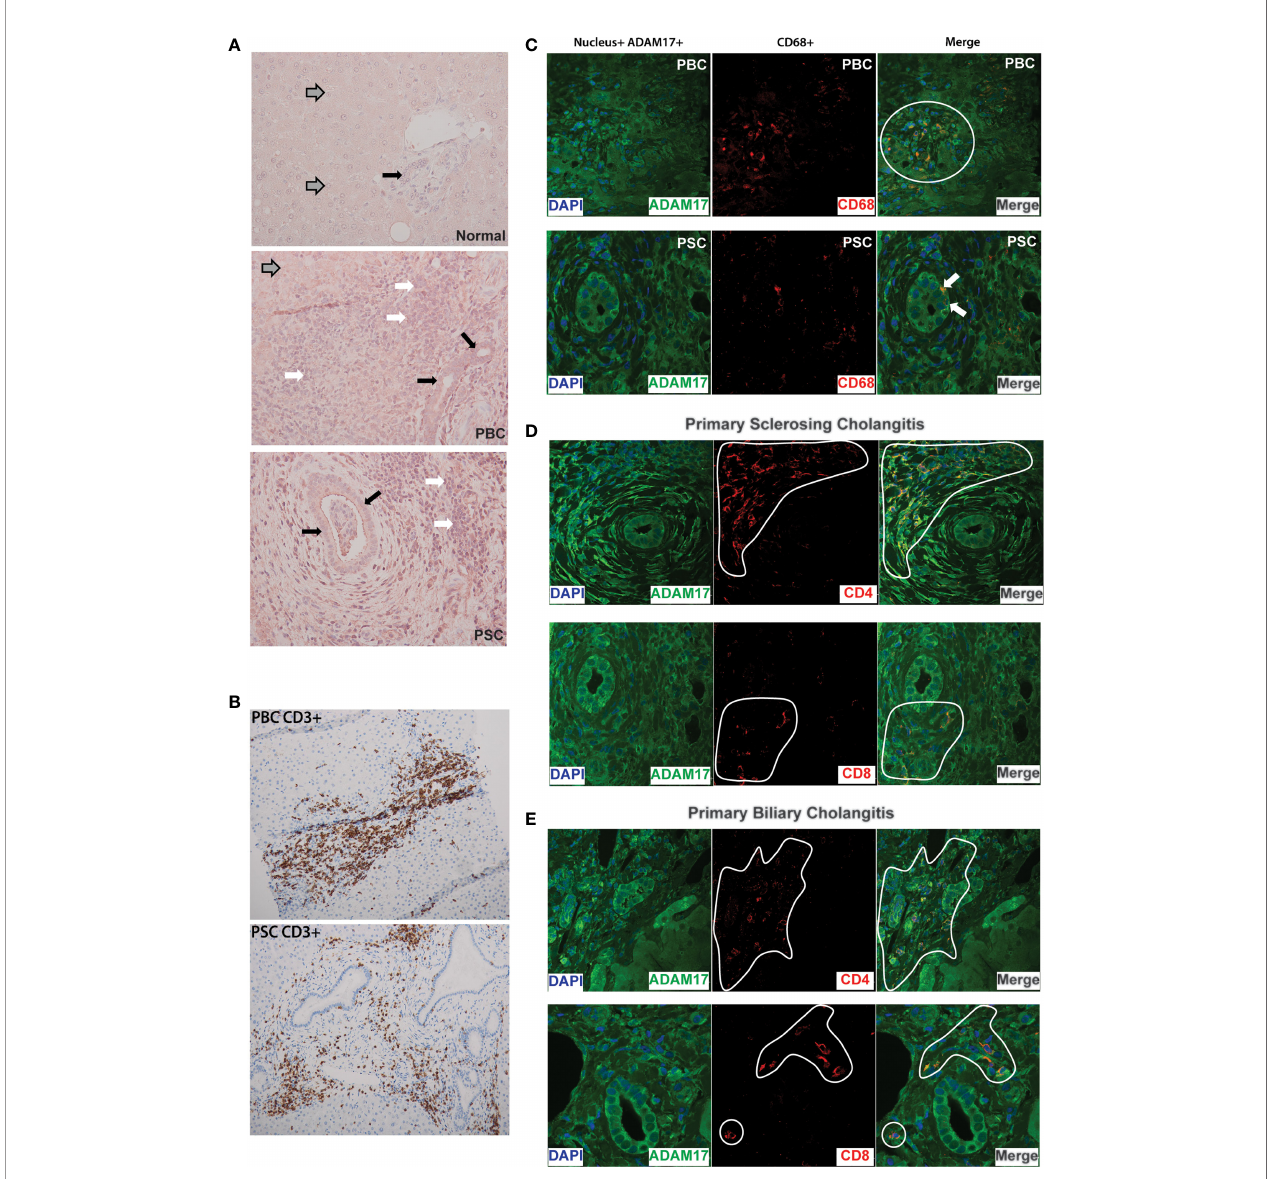
FIGURE 4 | (A) Increased ADAM17 protein expression in PBC and PSC livers: Representative immunohistochemical images (20X) showing increased hepatic ADAM17 protein expression in patients with Primary Biliary Cholangitis (PBC; middle panel) and Primary Sclerosing Cholangitis (PSC; bottom panel) compared to normal liver (top panel). Images are representative of similar fi ndings in n = 3 liver samples/group. For all three panels grey arrows indicate hepatocytes, white arrows indicate in fl ammatory in fi ltrate, and solid black arrows indicate cholangiocytes. Relative to normal liver, ADAM17 protein expression (red staining) is markedly increased in PBC and PSC. (B) Portal in fl ammatory in fi ltrates in PBC and PSC are mainly composed of T lymphocytes: CD3+ T cells within immune cell in fi ltrates in in fl amed portal areas of liver biopsies from patients with PBC (Top Panel) and PSC (Bottom Panel). Images acquired at 20X and are representative of similar fi ndings in n = 3 patients/group. Positive staining is indicated by amber/brown color. (C) Expression of ADAM17 (green colour) on the cell surface of CD68+ monocytes/macrophages (red colour) in PBC and PSC liver samples. Nuclei are stained blue. Images are representative of similar fi ndings in n = 3 patients/group. ADAM17+ CD68+ cells were readily identi fi ed within in fl ammatory cell in fi ltrates within portal areas (white circle in PBC sample). Interestingly, in PSC liver sections only, ADAM17+CD68+ monocytes could also be identi fi ed in fi ltrating between bile duct (BD) cholangiocytes (denoted by white arrow). (D) ADAM17 (green colour) expression on CD4 + and CD8 + T lymphocyte subsets (red colour) in liver biopsies from patients with PSC. Nuclei are stained blue. Images are representative of similar fi ndings in n = 3 PSC patients. ADAM17 expression by both CD4 + and CD8 + T cells was readily noted within in fl ammatory in fi ltrates (denoted by white highlight) within expanded portal areas in PSC livers. Increased ADAM17 expression was also noted in hepatocytes (not shown) and biliary epithelium/cholangiocytes. (E) ADAM17 (green colour) expression on CD4 + (top panels) and CD8 + (bottom panels) T lymphocyte subsets (red colour) in liver biopsies from patients with PBC. Nuclei are stained blue. Images are representative of similar fi ndings in n = 3 PBC patients. ADAM17 expression by both CD4 + and CD8 + T cells was readily identi fi ed within in fl ammatory in fi ltrates (denoted white line) within expanded portal areas in PBC livers. Increased ADAM17 expression was also noted in hepatocytes and biliary epithelium/cholangiocytes. All images are representative of other patient PBC and PSC samples. Experiments were repeated total 2 times with similar